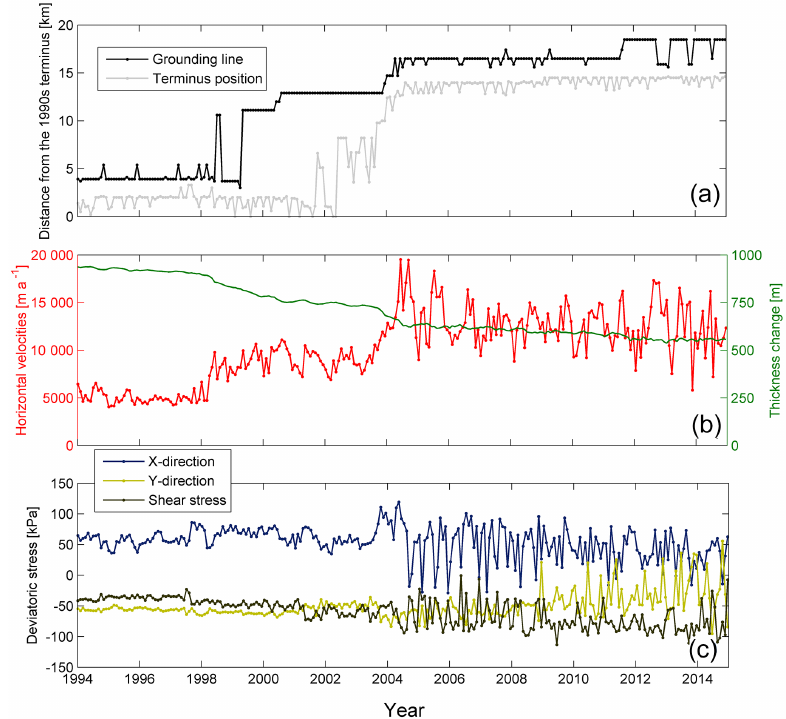
Figure 7. (a) Modelled grounding line and terminus position (floating ice tongues thinner than 50m are not shown). (b) Modelled horizontal velocities and ice thickness changes at the point location S1 shown in Fig. 1c. (c) Modelled two-dimensional deviatoric stresses (in the X direction, the Y direction, and the shear stress) at the point location S1 shown in Fig.